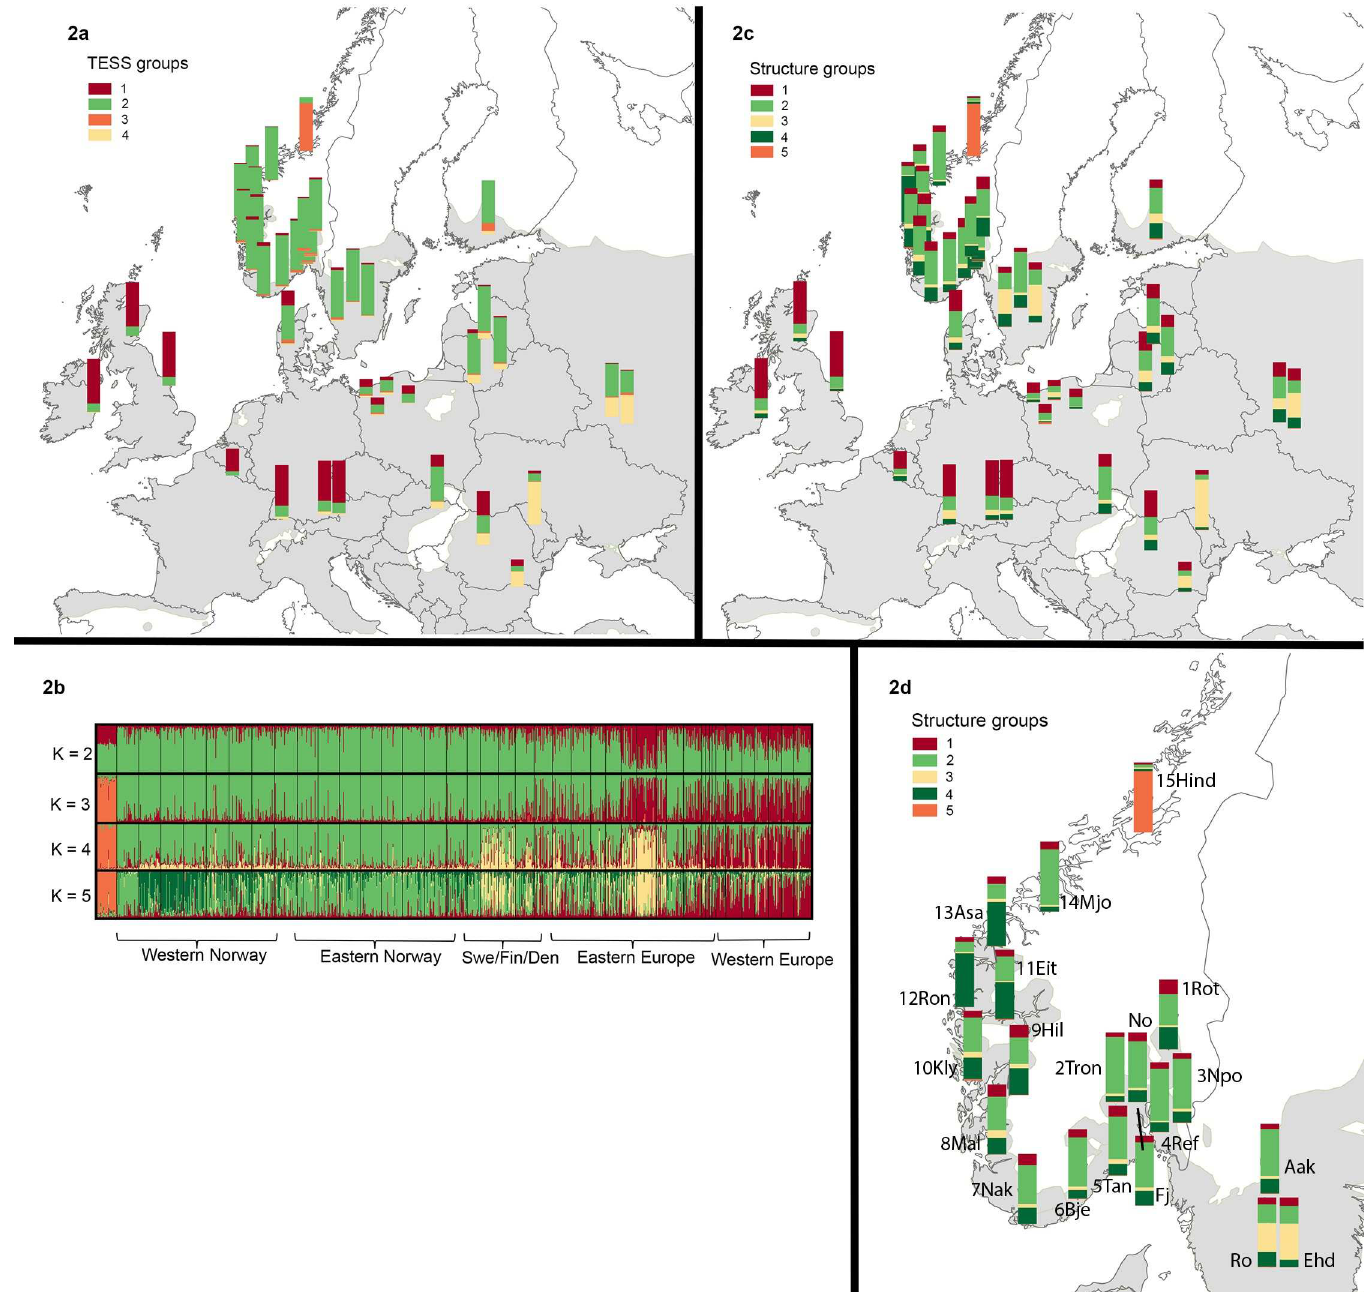
Fig 2. Distributionof TESS (2a) and STRUCTURE (2c, d) groupsin common ash ( Fraxinus excelsior )populations.2b shows bar plots of clustering basedon STRUCTURE for K = 2–5. The shadedgray areas represent the natural distributionrange of common ash [29].